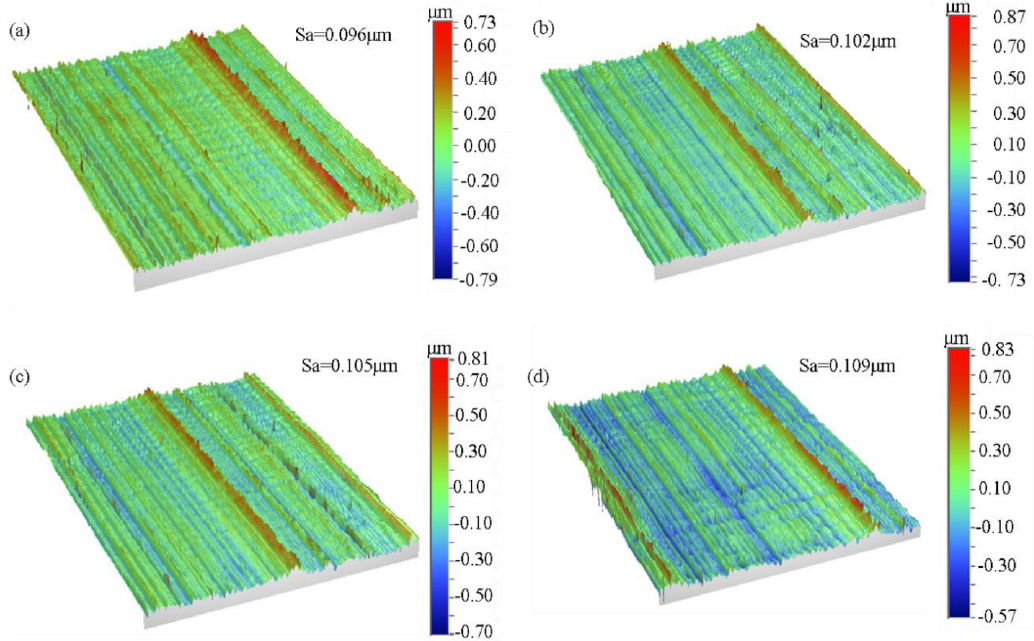
Figure 7. Roughness measuring the surface for the depth of cut corresponding to 8 µ m.